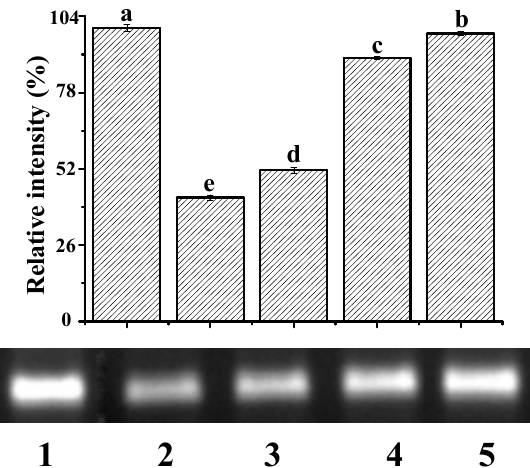
Figure 7. Protective effect of YP against ctDNA damage: Lane 1, DNA; Lane 2, DNA + ∙ OH; Lane 3, DNA + ∙ OH + 0.05 mg/mL YP; Lane 4, DNA + ∙ OH + 0.11 mg/mL YP; and Lane 5, DNA + ∙ OH + 0.17 mg/mL YP. Bar chart presents relative intensity of DNA band with respect to Lane 1 (DNA only).